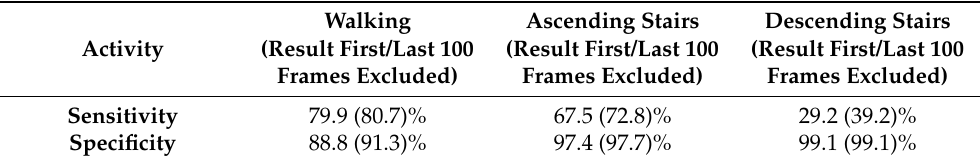
Table 4. Overall sensitivity and specificity of selected types of locomotion for testing dataset and dataset with exclusion of the first and last 100 frames of each walking and stair climbing period.